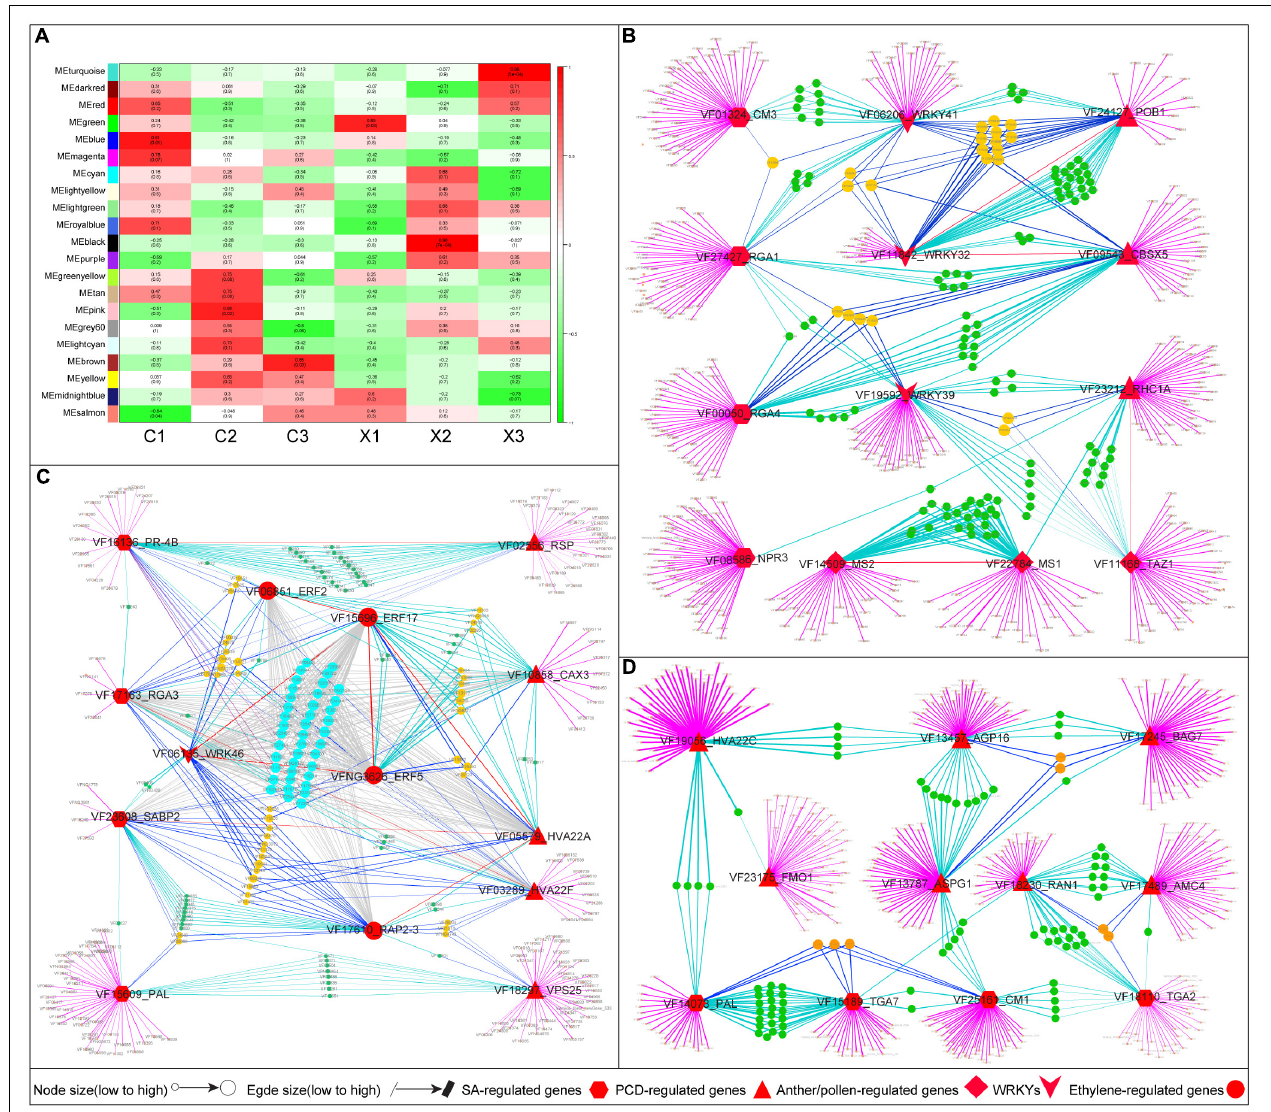
FIGURE 6 | Co-expression networks analysis of genes in different module of female flowers in tung tree. (A) Module trait relationships in six samples. (B–D) Co-expression networks analysis of anther and pollen development genes, SA- and PCD-related genes in MEblue, MEpink, and MEbrown